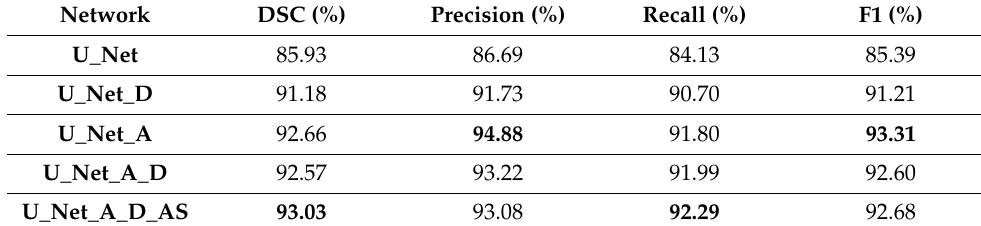
Figure 6. The network extraction results of different depths: ( a ) cropped color map image blocks, ( b ) labels of map line features produced, ( c ) the result of the network depth is 4, ( d ) the result of the network depth is 6, and ( e ) the result of the network depth is 8. Table 5. DSC, precision, recall, and F1-score of different basic